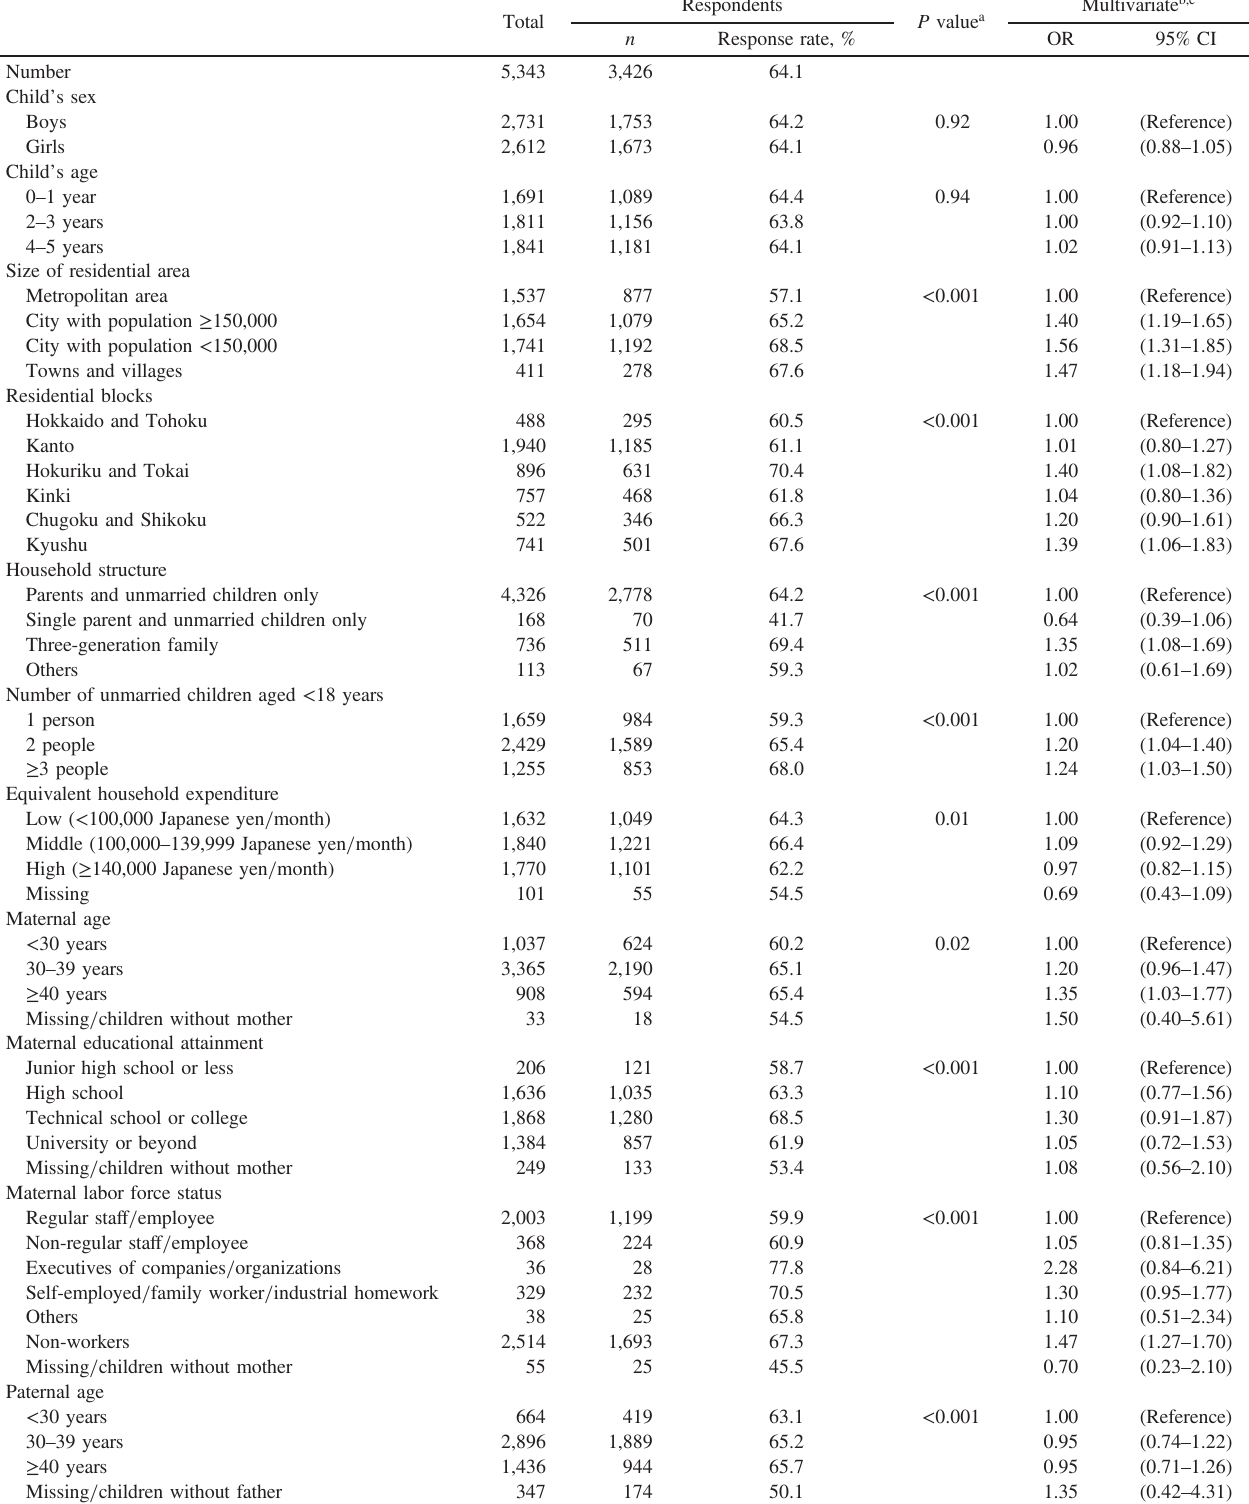
Table 1. Response rates and odds ratios for response to the 2015 National Nutrition Survey on Preschool Children, Japan, according to sociodemographic characteristics among children aged < 6 years and their